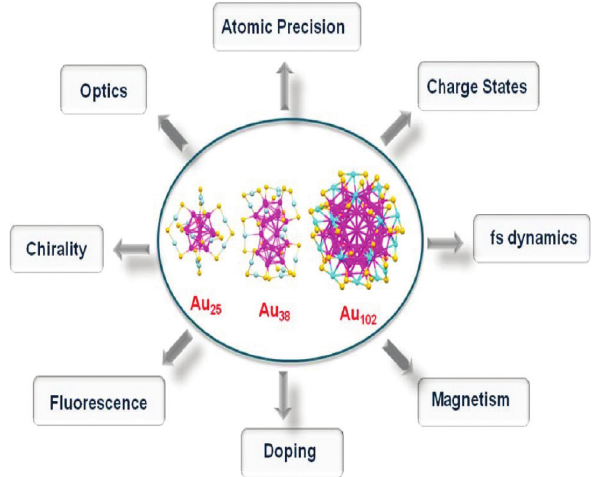
Figure 4: Properties of Au NCs. Reprinted image with permission from Ref. [40], Copyright 2012, American Chemical